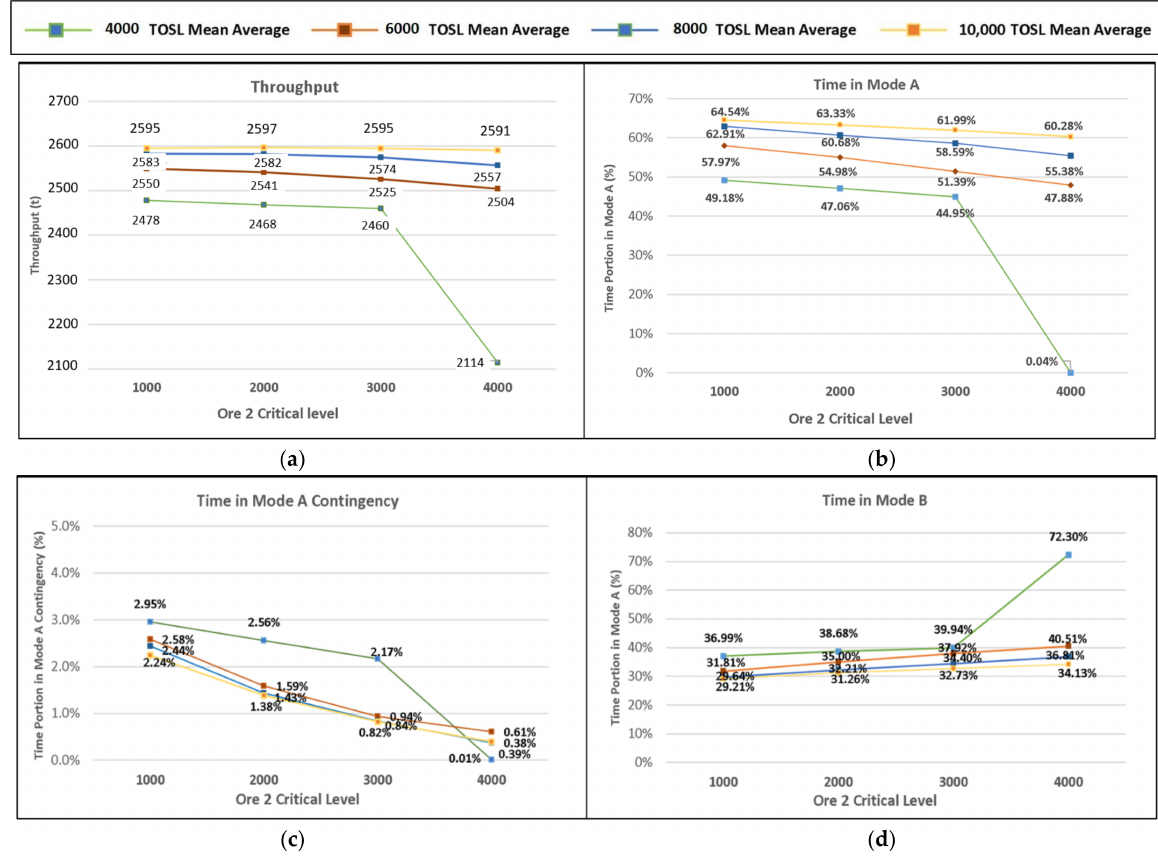
Figure 8. Main simulation statistics as a function of policy parameter target stockpile levels X = 10,000 t (Yellow line), 8000 t (Blue line), 6000 t (Red line), 4000 t (Green line), considering critical stockpile levels Y = 1000 t, 2000 t, 3000 t, 4000 t. ( a ) Mean Average Throughput. ( b ) Mean average time in Mode A. ( c ) Mean average time in Mode A Contingency. ( d ) Mean average time in Mode B.